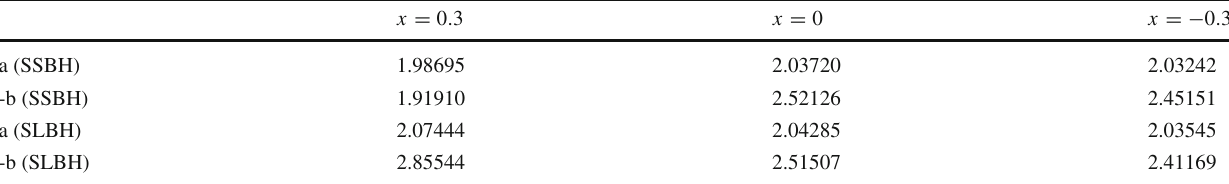
Table 1 Coefficients a and b of the fitting formulation along the saturated small black hole (SSBH) and saturated large black hole (SLBH) with x = 0 . 3, 0 and − 0 . 3 x = 0 . 3 x = 0 x = − 0 .